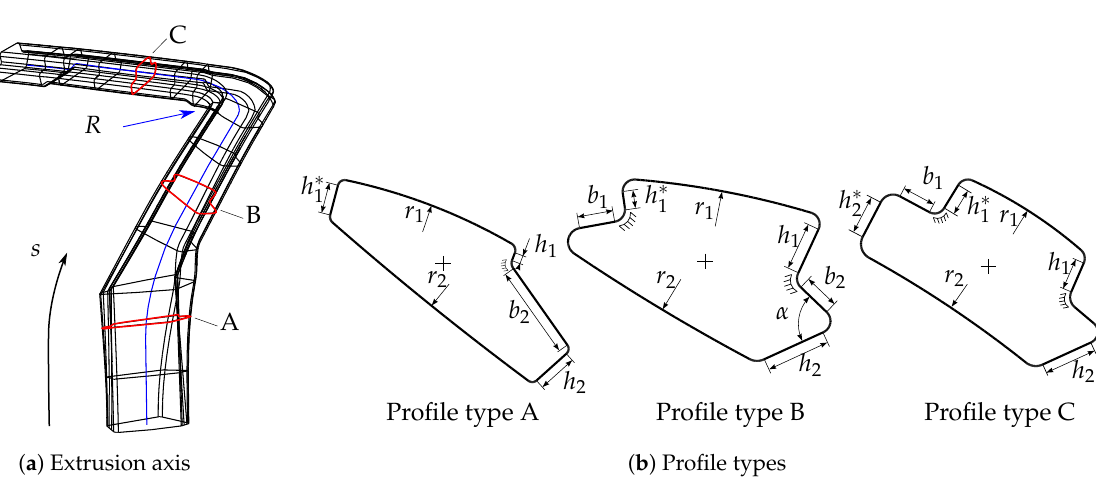
Figure A1. Extrusion axis and associated profile types A, B and C of the